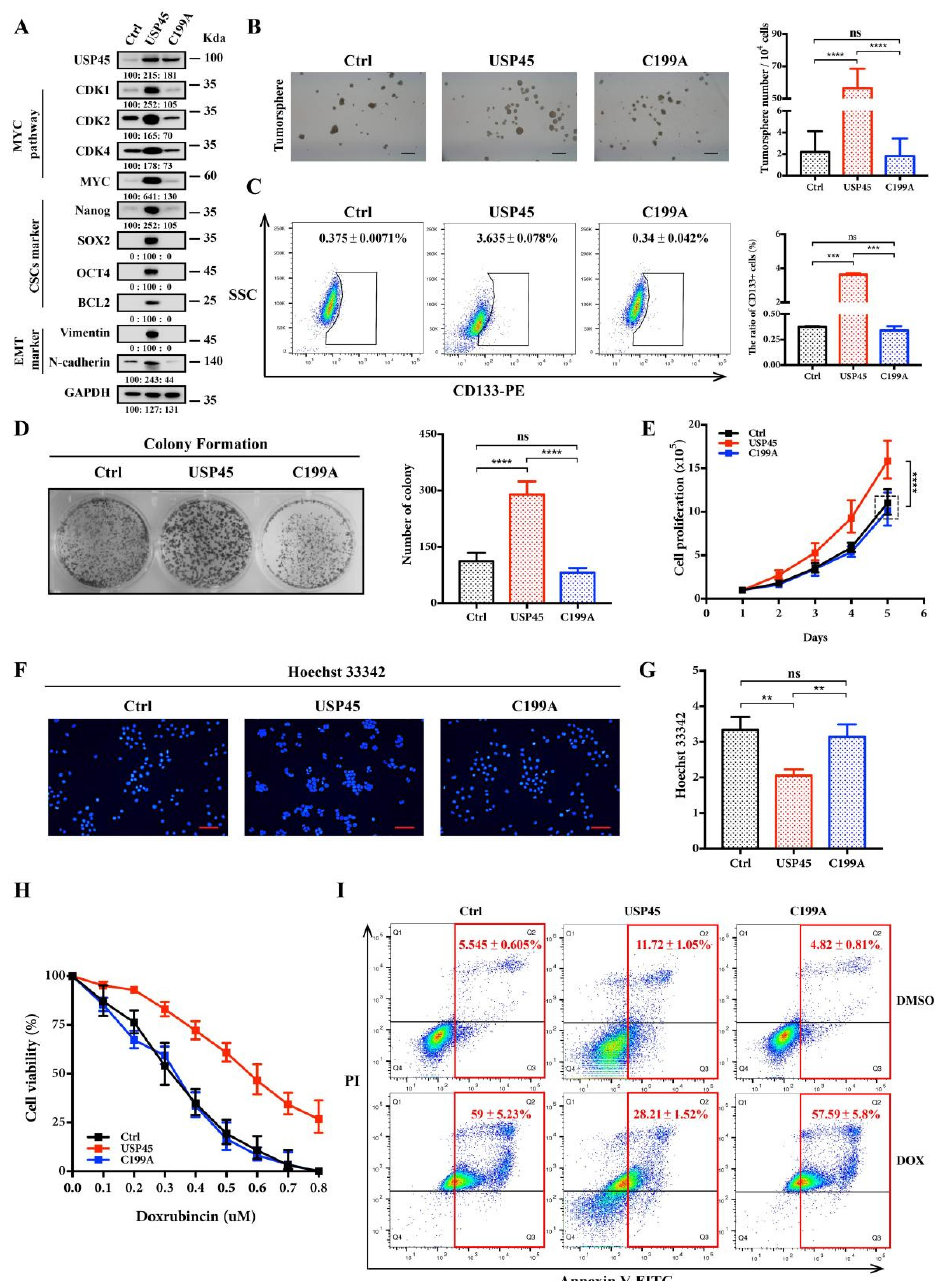
Figure 3. USP45 promotes the proliferation, stemness and drug resistance of cervical cancer cells. ( A – E ) SiHa cells stably expressing plvx-puro vector (the negative control), USP45 or C199A were subjected to ( A ) Western Blot analyses, ( B ) tumorsphere formation assay, ( C ) FACS analyses for CD133-stained cells, ( D ) colony formation assay, ( E ) cells proliferation assay and ( F , G ) Hoechst 33,342 stain analysis. ( H ) The SiHa cells treated with increasing concentrations of doxorubicin (DOX) were subjected to cell viability assay. ( I ) The SiHa cells treated with 0.5 µM doxorubicin for 48 h were subjected to FACS analyses for Annexin V/PI-stained cells. Respective images and quantitation were shown. Data from independent experiments in duplicates were presented as means ± SD: p > 0.05 (no significance/ns), ** p < 0.01, *** p < 0.001, **** p < 0.0001. Scale bar is 100 µm in size. Experiments were conducted at least two times in duplicates.